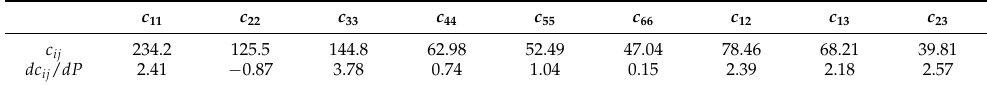
Table 2. Elastic constants c ij (in GPa) at 0 GPa and pressure